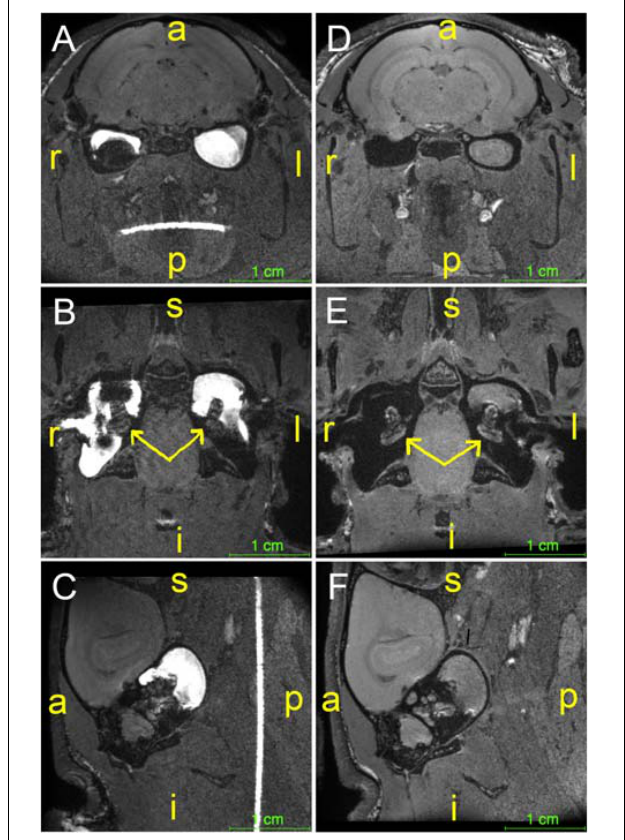
FIGURE 4 | Animals in the Thio-25-cispt group (presented in Figure 2 ) were euthanized after hearing threshold assessment on day 10. Their cochleae were collected to quantify hair cell loss. Repeated measures ANOVA of the percentage loss of outer hair cells (OHCs) in the first (OHC1), second (OHC2), and third (OHC3) rows are shown for ears injected with a thiosulfate- containing gel (Thio-25) and for the contralateral, non-injected ear (None). §§§ signifies p < 0.001.